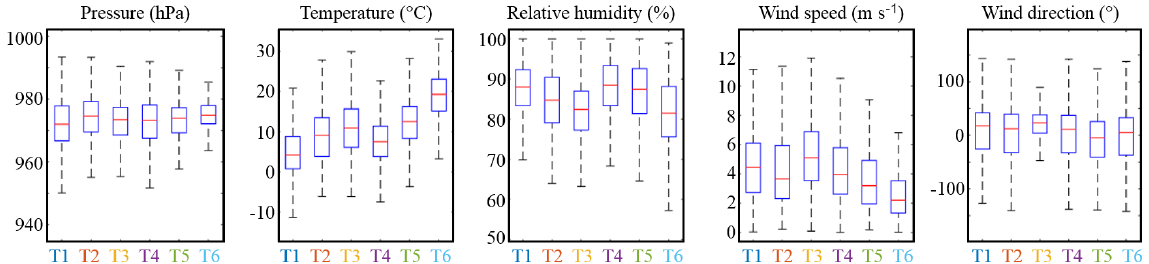
Figure 4. Statistics of meteorological covariates for each rain type. The meteorological data were extracted from the ERA5 reanalysis